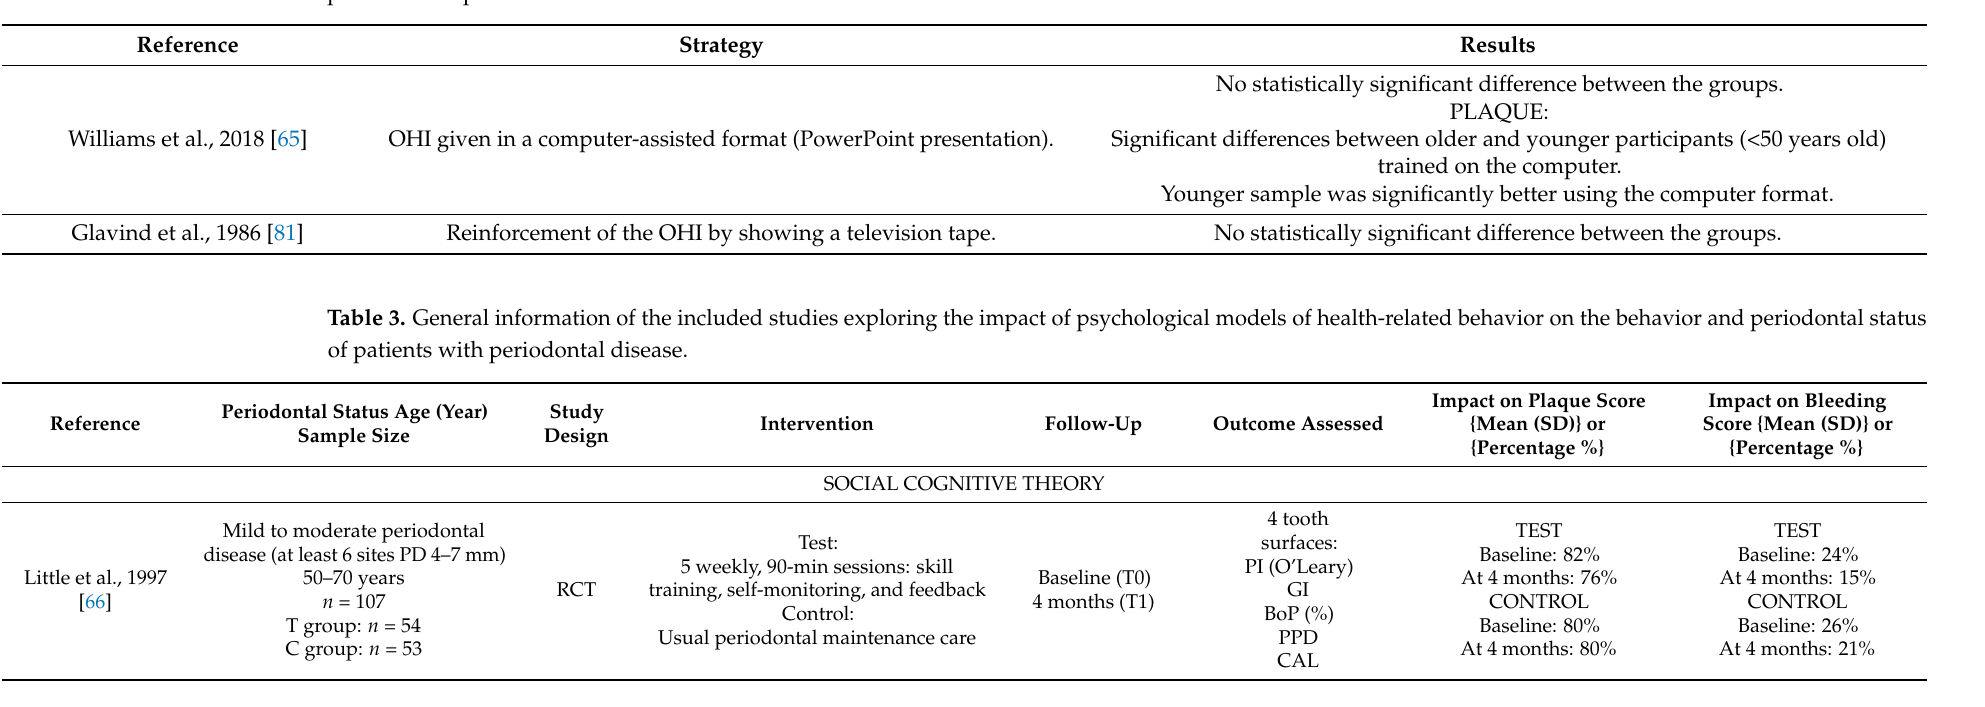
Table 2. Summary of the strategy and results of the included studies exploring the impact of OH instructional mode on the behavior and periodontal status of patients with periodontal disease.